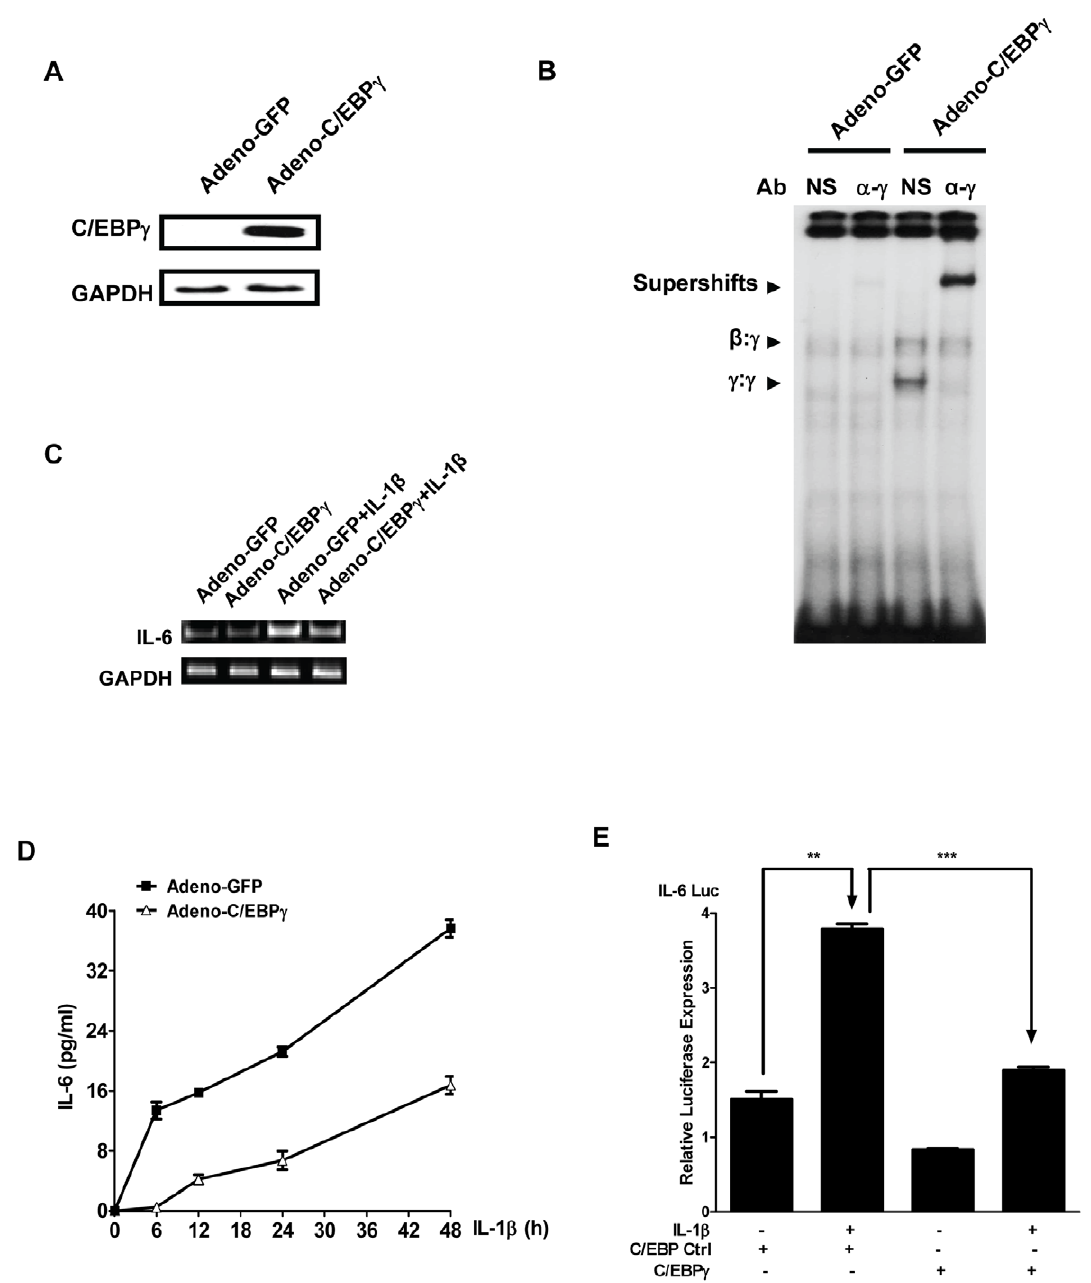
Figure 2. Ectopic expression of C/EBP c inhibits IL-1 b -mediated IL-6 expression in MLE12 cells. A, MLE12 cells were infected with control adenovirus (Adeno-GFP) or C/EBP c expressing adenovirus (Adeno-C/EBP c ) at 20 MOI. 24 h after infection, total protein were harvested and subjected to Western blot using antibodies against C/EBP c and GAPDH, respectively. B, MLE12 cells were infected with Adeno-GFP or Adeno-C/EBP c at 20 MOI. 24 h later, the nuclear extracts were subjected for EMSA. NS and a - c represent normal rabbit IgG, and anti-C/EBP c antibody, respectively. Arrows indicated C/EBP binding species and supershift bands. C and D, MLE12 cells were infected with Adeno-GFP or Adeno-C/EBP c at 20 MOI. 24 h later, the cells were stimulated with or without 20 ng/ml IL-1 b for indicated time periods. C, RNAs were isolated and RT-PCR was conducted using primers for IL-6 and GAPDH, respectively. D, the supernatants were harvested for ELISA. Data were expressed as means 6 S. E. M., N=8. E, MLE12 cells were transfected with indicated plasmids. 24 h later, the cells were treated with or without 20 ng/ml IL-1 b . Cell lysates were subjeceted for luciferase activity measurement. Luminometer values were normalized for expression from a co-transfected thymidine kinase reporter gene. The data were expressed as means of three experiments 6 S. E. M. ** and *** indicated statistically significant difference- p , 0.01 and p , 0.001, respectively.